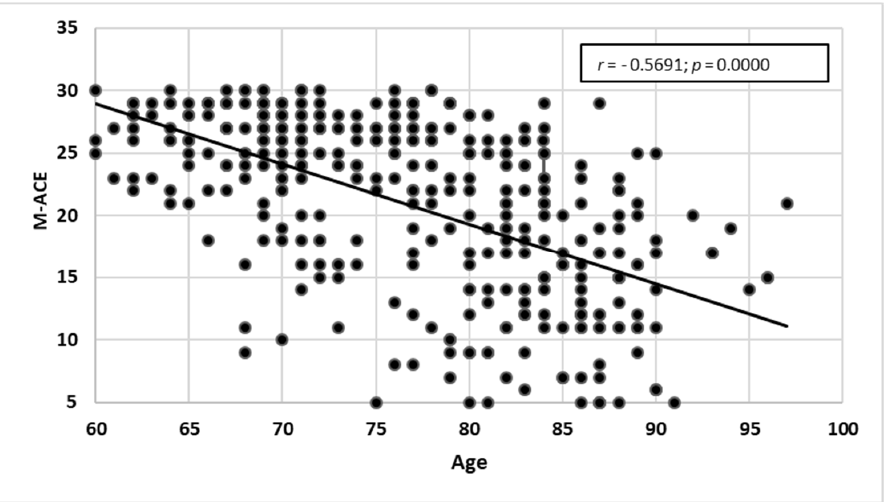
Figure 5. Age correlated with M-ACE test results.